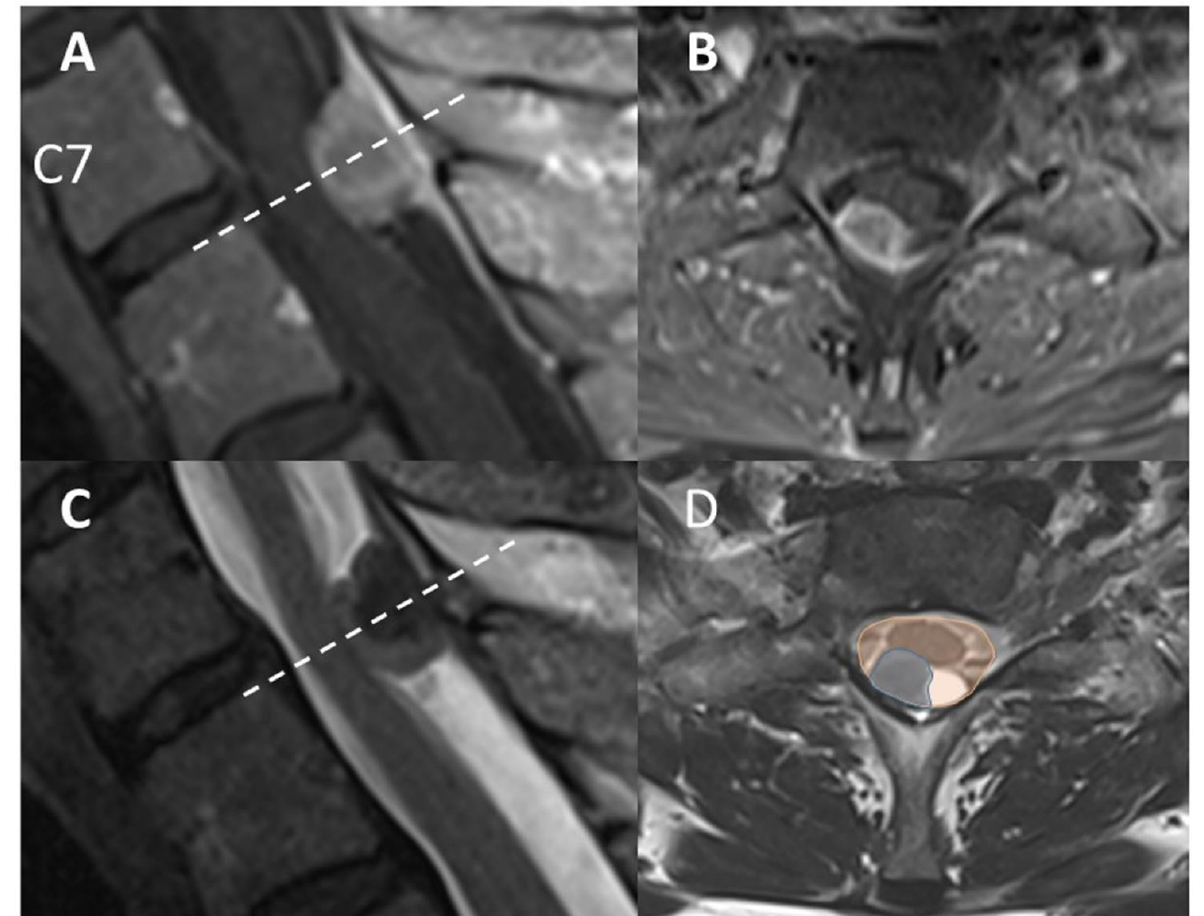
Figure 1. ( A , B ) Preoperative sagittal and axial T1-weighted contrast-enhanced MR images show an intradural extramedullary lesion at T1 – 2 with displacement of the spinal cord. ( C , D ) Preoperative sagittal and axial T2-weighted MR images. ( D ) measurement of the tumor-canal ratio (TCR), blue: cross-sectional area of tumor at level of maximum expansion, orange: spinal canal area.